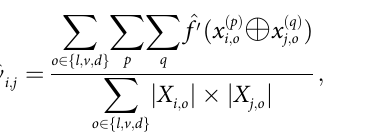
PLOS Computational Biology | https://doi.org/10.1371/journal.pcbi.1007324 September 17,